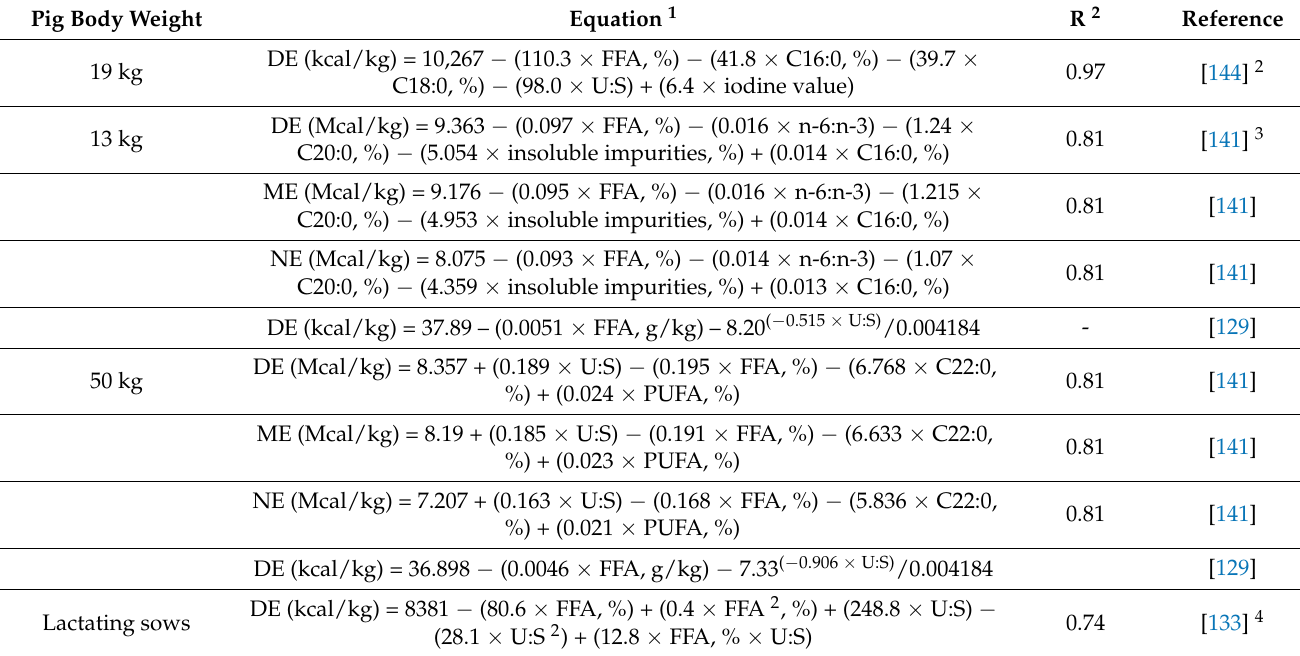
Table 8. Summary of published digestible energy (DE), metabolizable energy (ME), and net energy (NE) prediction equations for lipids fed to